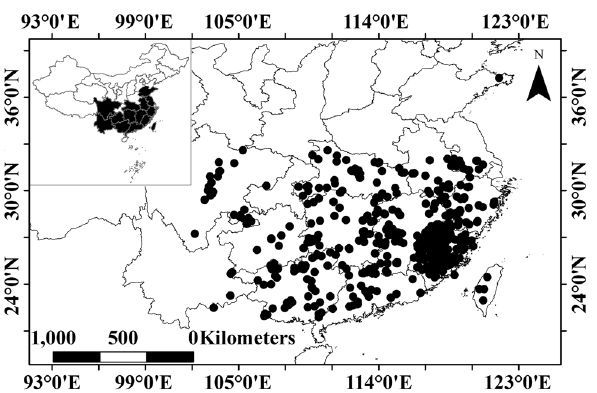
Figure 1. Study sites of Chinese fir in China, including Anhui, Fujian, Guangdong, Guangxi, Guizhou, Henan, Hubei, Hunan, Jiangsu, Jiangxi, Shandong, Sichuan, Taiwan, Yunnan, Zejiang provinces. The x-axis is longitude and y-axis is latitude. This figure was generated by the software QGIS 3.10.14 (https:// www. qgis. org/ en/